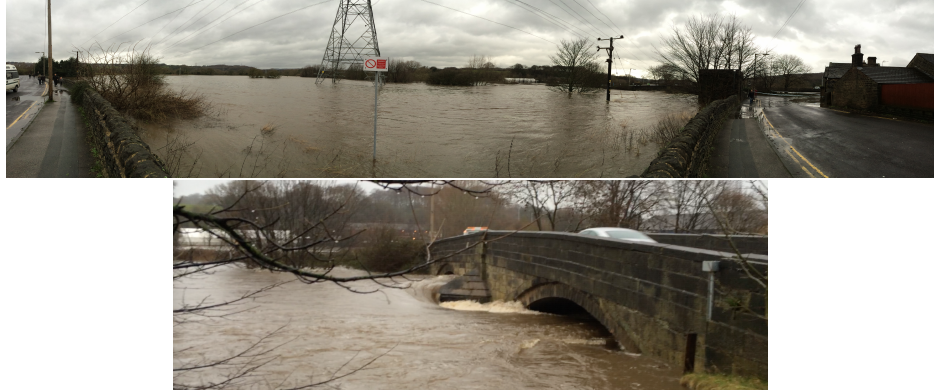
Figure 2. Boxing Day 2015 flooding levels of the River Aire near Apperley Bridge (river near the yellow marker in Figure 1; the old bridge just upstream of the modern A658-road bridge). Top : the filled flood plain upstream of the bridge constriction at 09:56:04 on 26 December 2015. Bottom : the flow under Apperley Bridge at circa 09:58:30 on the same date, showing the dangerous proximity to choking, akin to experiments in [11]. Photo and video-grab courtesy of